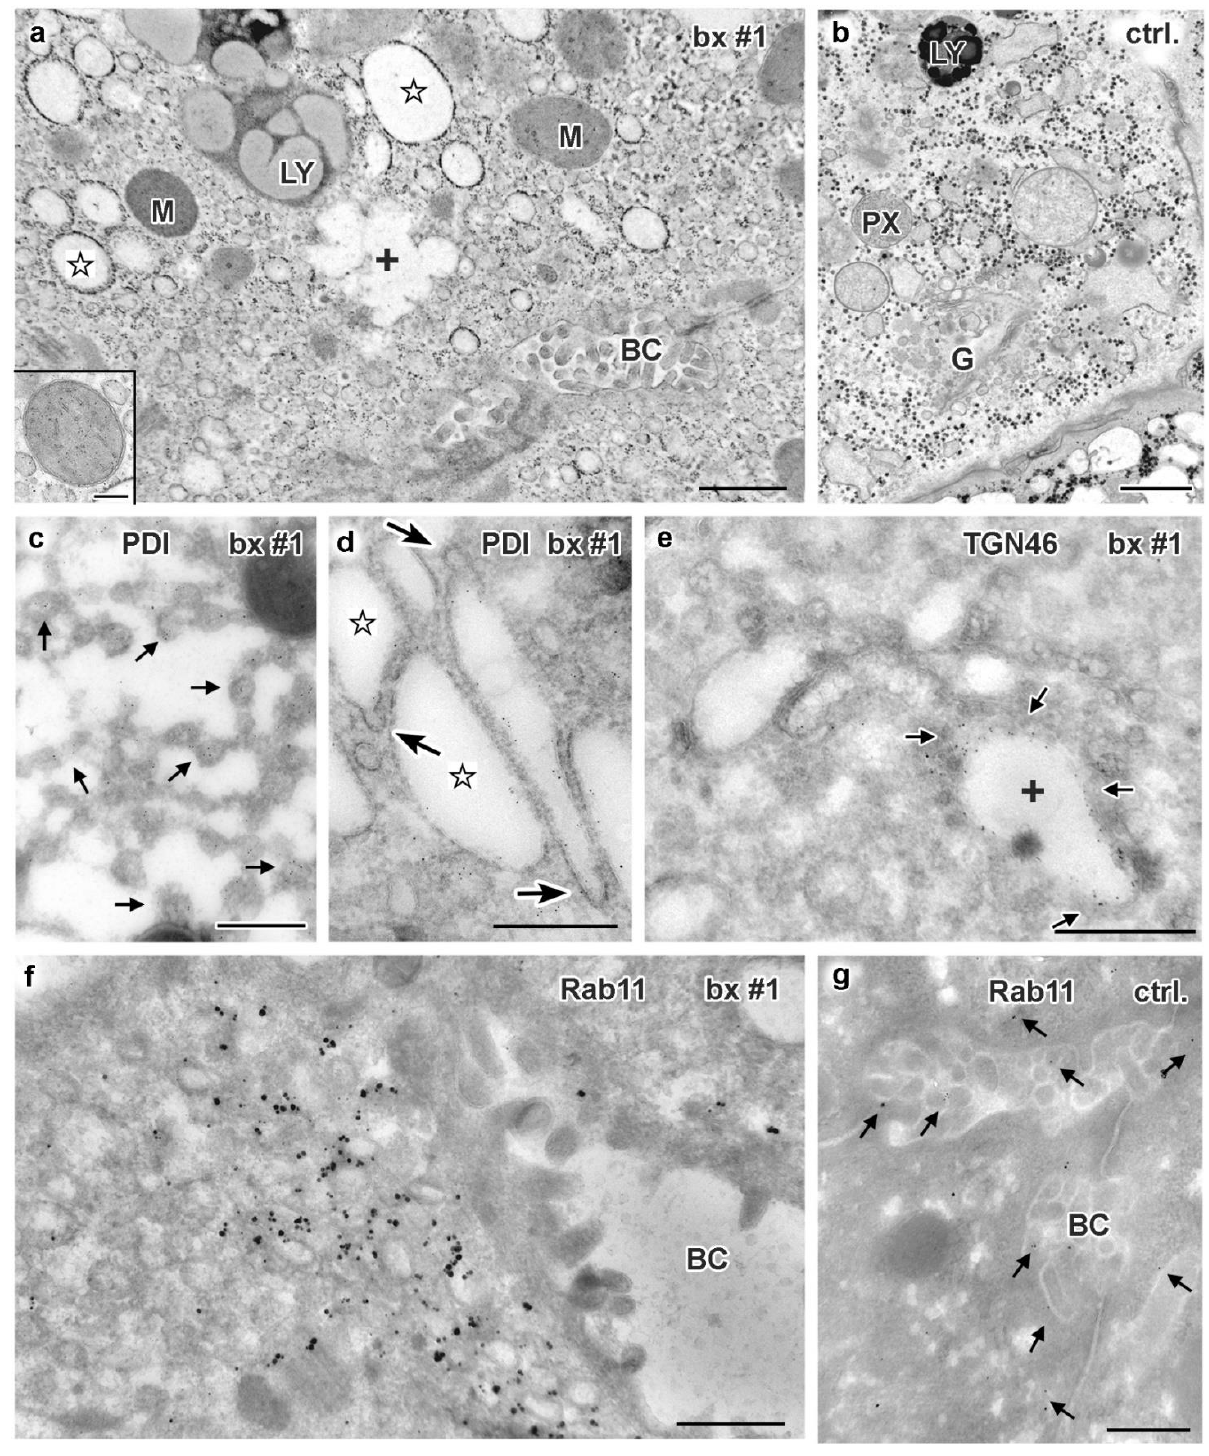
Figure 9. Ultrastructure and immuno-gold EM of aldehyde-fixed liver biopsies from MYO5B-PFIC patient #1 (a,c–f) and control (b,g). ( a ) Endomembrane compartments distinguished in MYO5B-PFIC sample comprise large, ribosome-decorated unstained cisternae (marked by stars), ill-defined “swollen membrane sacks” (marked by a cross: +), abundant small vesicles and lysosomes (LY). Mitochondria (M) appear normal, peroxisomes and locally occurring large lipid droplets (indicating steatosis) are not shown in this frame of apical hepatocyte area facing bile canaliculus (BC); scale bar = 1 µ m. Insert